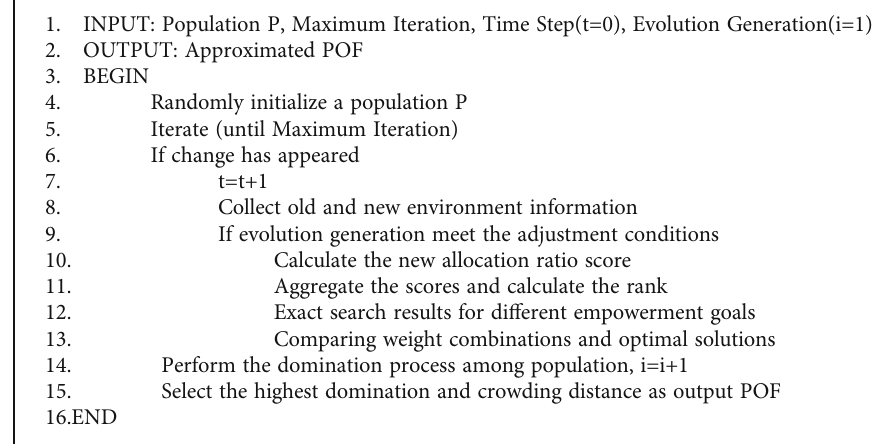
Algorithm 1: Algorithm for dynamic multiobjective